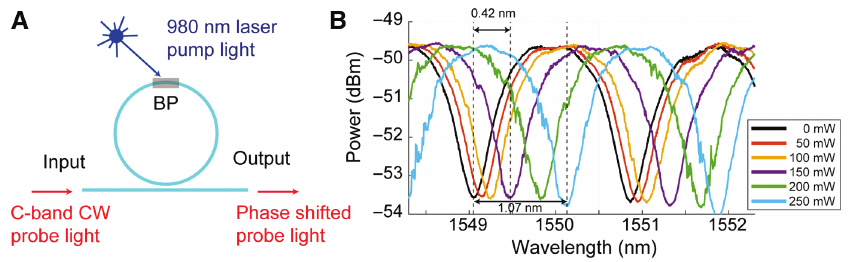
Figure 2: The schematic diagram and results for free-space pumping. (A) Sketch of the modulator when 980-nm pump light is applied from outside space. (B) Transmission spectra of the MRR for different pumping